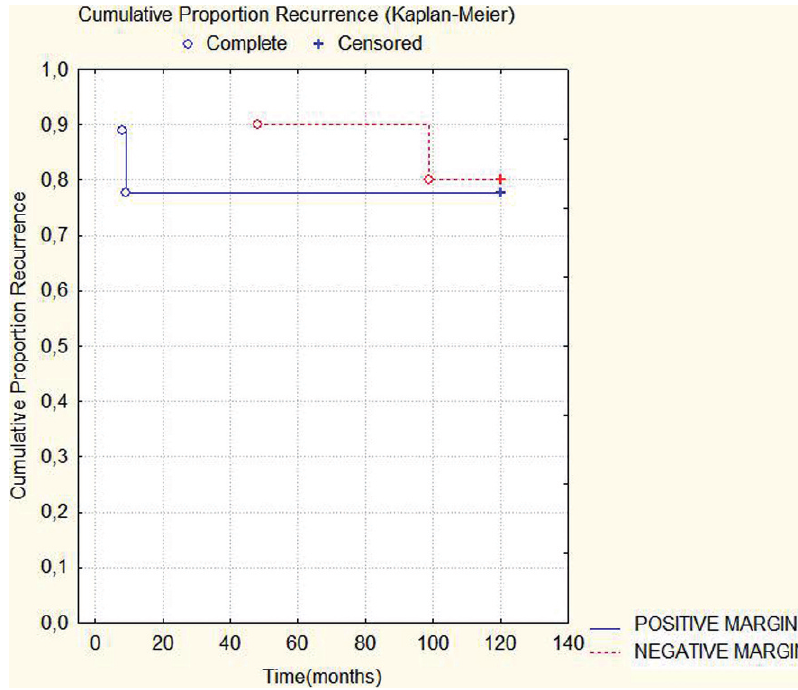
Figure 3 - Cumulative proportion of recurrence events during follow-up